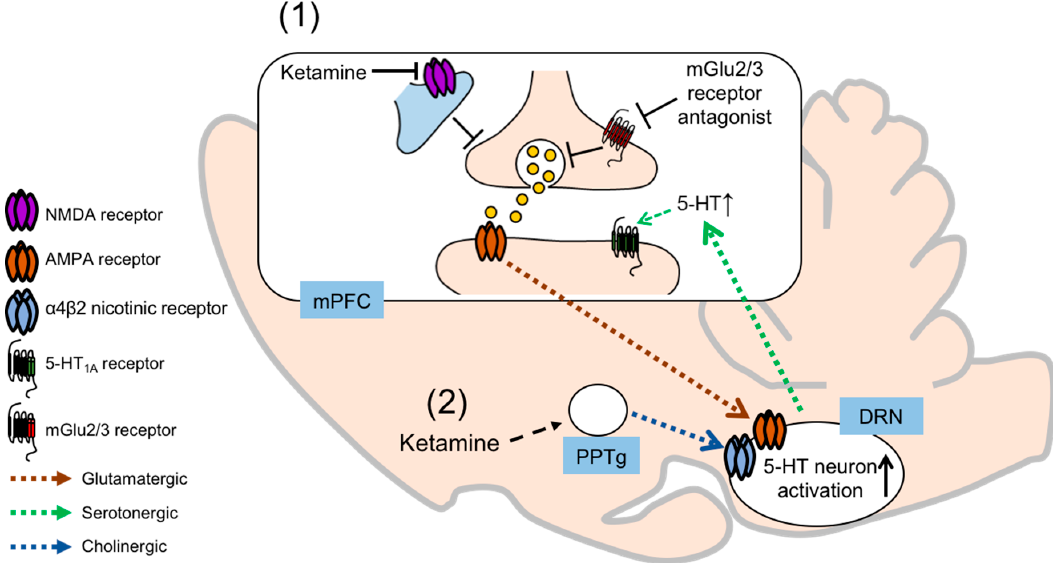
Figure 1. Proposed serotonergic mechanisms through which mGlu2/3 receptor antagonists and ketamine exert their antidepressant effects. Both mGlu2/3 receptor antagonists and ketamine increase 5-HT release in the medial prefrontal cortex (mPFC) through activation of 5-HT neurons in the dorsal raphe nucleus (DRN). There are two hypotheses by which mGlu2/3 receptor antagonists and ketamine activate 5-HT neurons in the DRN. (1) mGlu2/3 receptor antagonists and ketamine activate neurons in the mPFC projecting to 5-HT neurons in the DRN. Stimulation of AMPA receptor both in the mPFC (to activate neurons projecting to the DRN) and in the DRN (to activate 5-HT neurons) may be involved in this pathway. mGlu2/3 receptor antagonists and ketamine indirectly stimulate AMPA receptor by increasing glutamate release in different manners. (2) Ketamine activates cholinergic neurons in the pedunculopontine tegmental nucleus (PPTg), projecting to the DRN neurons where α 4 β 2 nicotinic receptor, together with AMPA receptor, activates 5-HT neurons. Activation of 5-HT neurons in the DRN leads to increase in 5-HT release in the mPFC, and stimulates postsynaptic 5- HT 1A receptor.